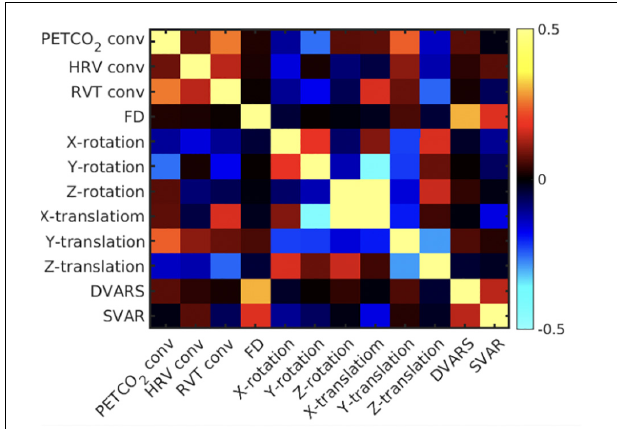
FIGURE 4 | Mean correlation matrix across all pairs of noise regressors. The correlation matrix is the average across subjects. The colorbar represents correlation coefficients, and the diagonal are populated by